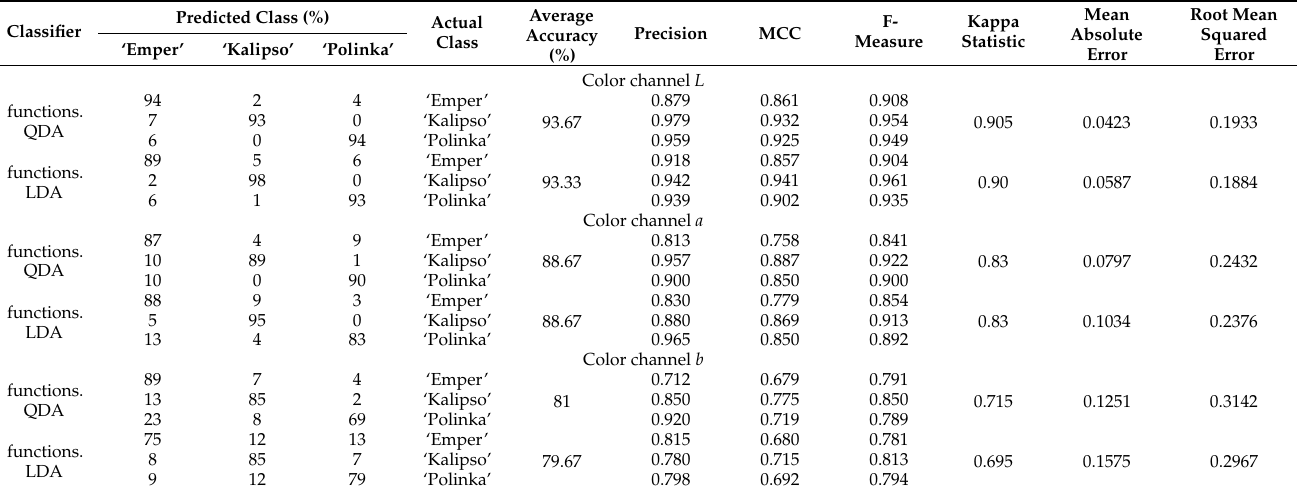
Table 3. The metrics of cultivar discrimination of plum stones based on textures selected from individual color channels L , a , b